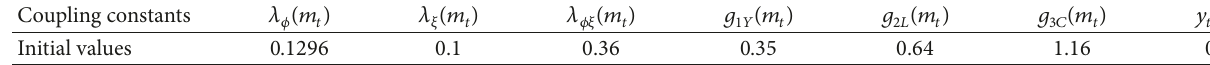
Table 6: Initial values of coupling constants at top quark mass.